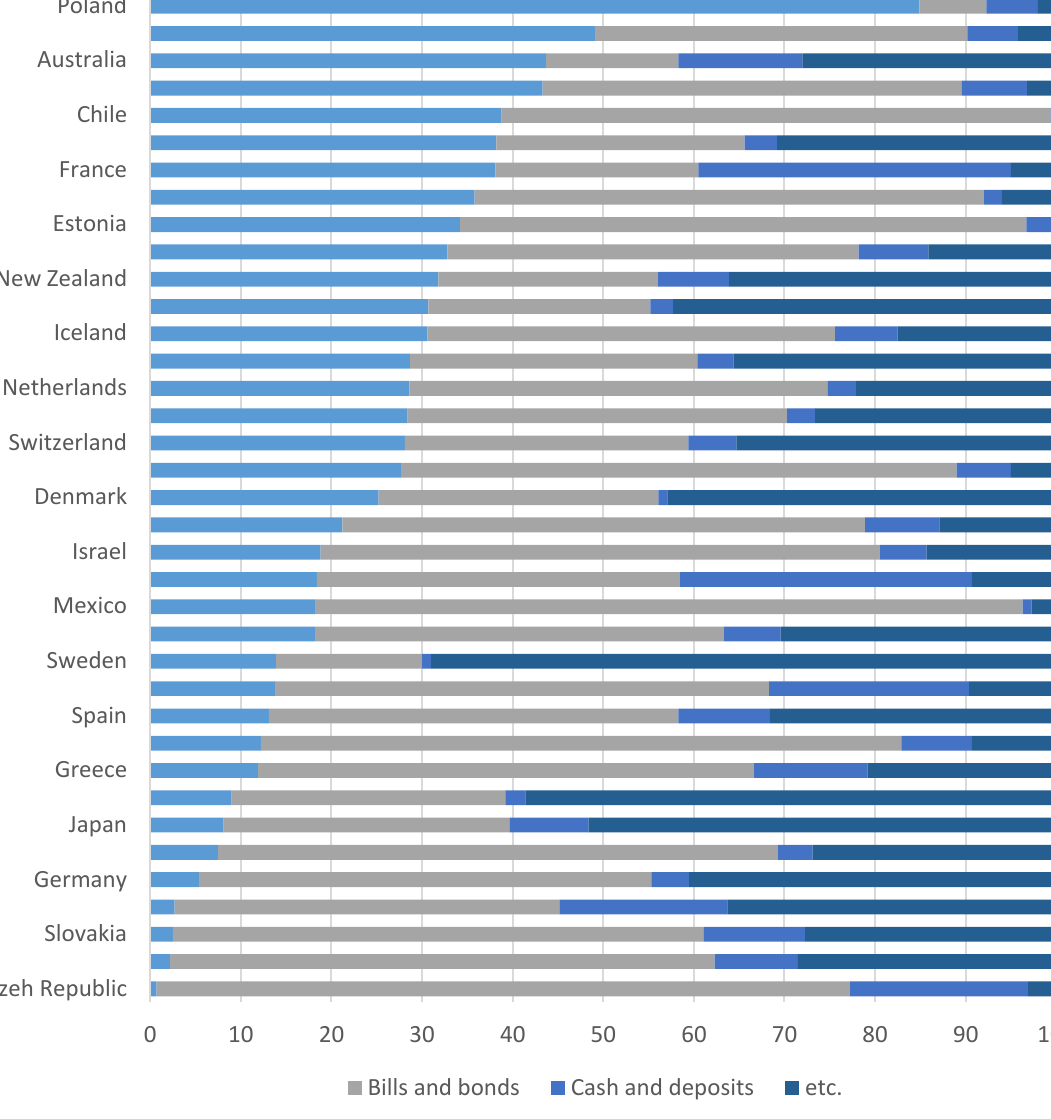
Figure 2. Structures of investment portfolios of private pension funds in some countries of the world in 2018,